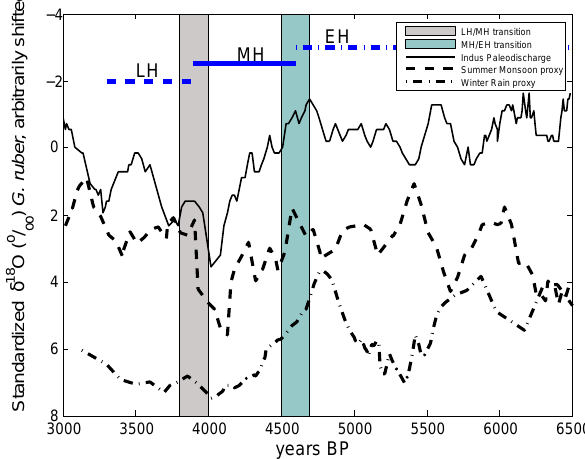
Fig. 7. The paleo-discharge and rains record during the rise and the dispersal of the Indus Tradition. The data are standardized by subtracting the mean and dividing by the standard deviation of the time series. Also shown are the transitions between EFG (early food producing) and EH; EH and MH and MH and LH. Com- piled from Staubwasser et al. (2003), Stott (2008), Bar-Matthews et al. (2003) and Kenoyer (2006). LH = Late Harappan Era, MH = Mature Harappan Era, EH = Early Harappan Era.